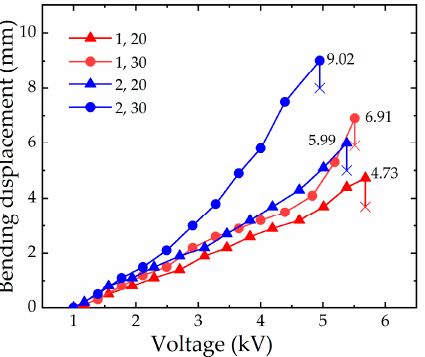
Figure 10. Experimental results of the different amounts of compression.